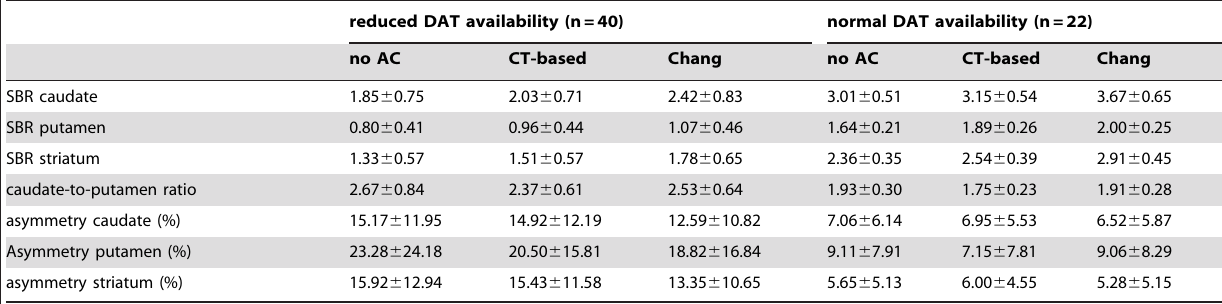
Table 2. Results of the semi-quantitative analysis of the patient